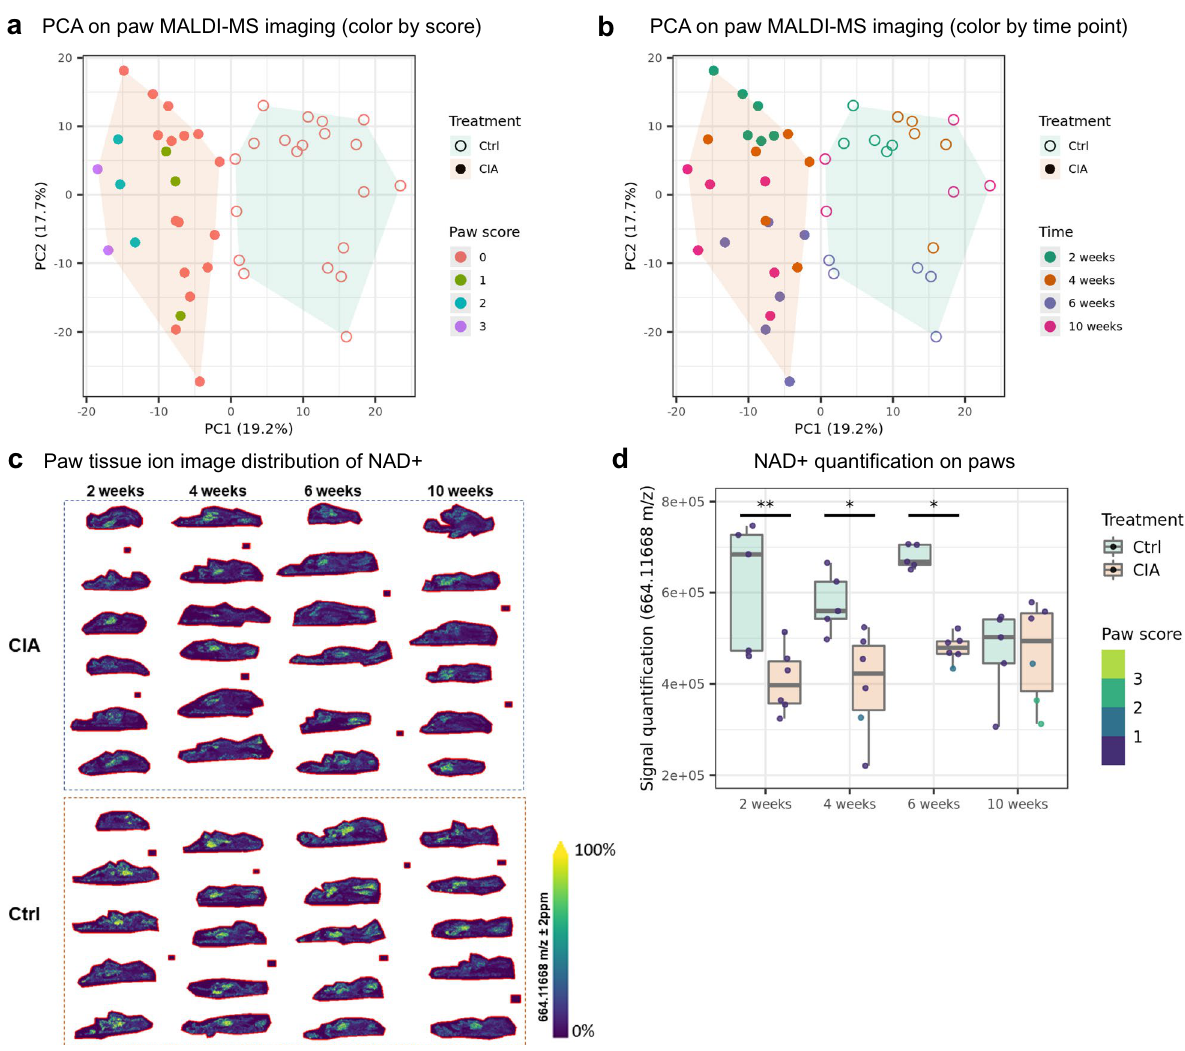
Figure 4. Tissue MALDI-MS imaging showed reduction of NAD+ in CIA paws. Tissue MALDI-MS imaging on left front paws from control and CIA mice at different disease stages. At each time point, the sample size for controls is 5 and the sample size for CIA is 6. ( a ) PCA score plot with paw samples color-coded by their respective arthritis scores. ( b ) PCA score plot with paw samples color-coded by their respective sacrifice time points. ( c ) NAD+ distribution on paw tissue ion image per mouse. Cryosections of mouse paws were analyzed by MALDI-MS tissue imaging mass spectrometry. The mass to charge 664.11668 was assigned to NAD+ with a mass accuracy of 0.4 ppm and its TIC (T = Total Ion Count) normalized tissue distribution is shown at a spatial lateral resolution of 50 × 50 µm. The color legend reflects the relative intensity [Arb.U] distribution from 0 to 100%. ( d ) Image signal quantification of NAD+ on paws. Two-way ANOVA with Tukey multiple pairwise- comparisons was done (p adj < 0.05*, p adj < 0.01**, p adj <